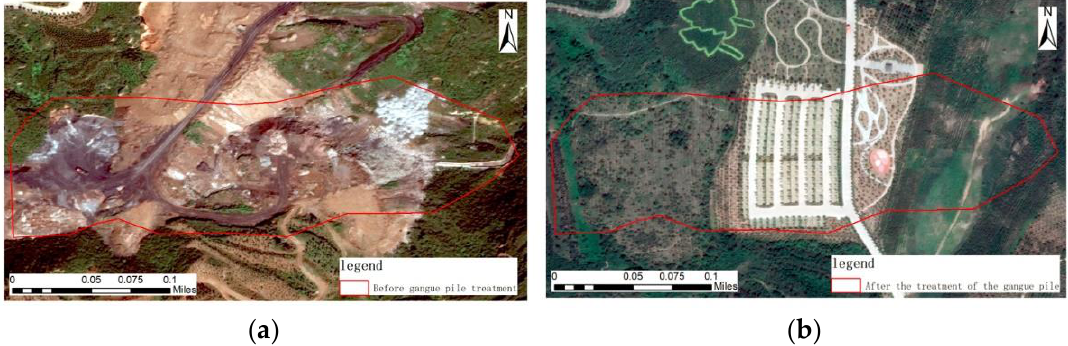
Figure 8. Remote sensing images before and after ecological restoration in the coal gangue treatment area. ( a ) before treatment; ( b ) after treatment.